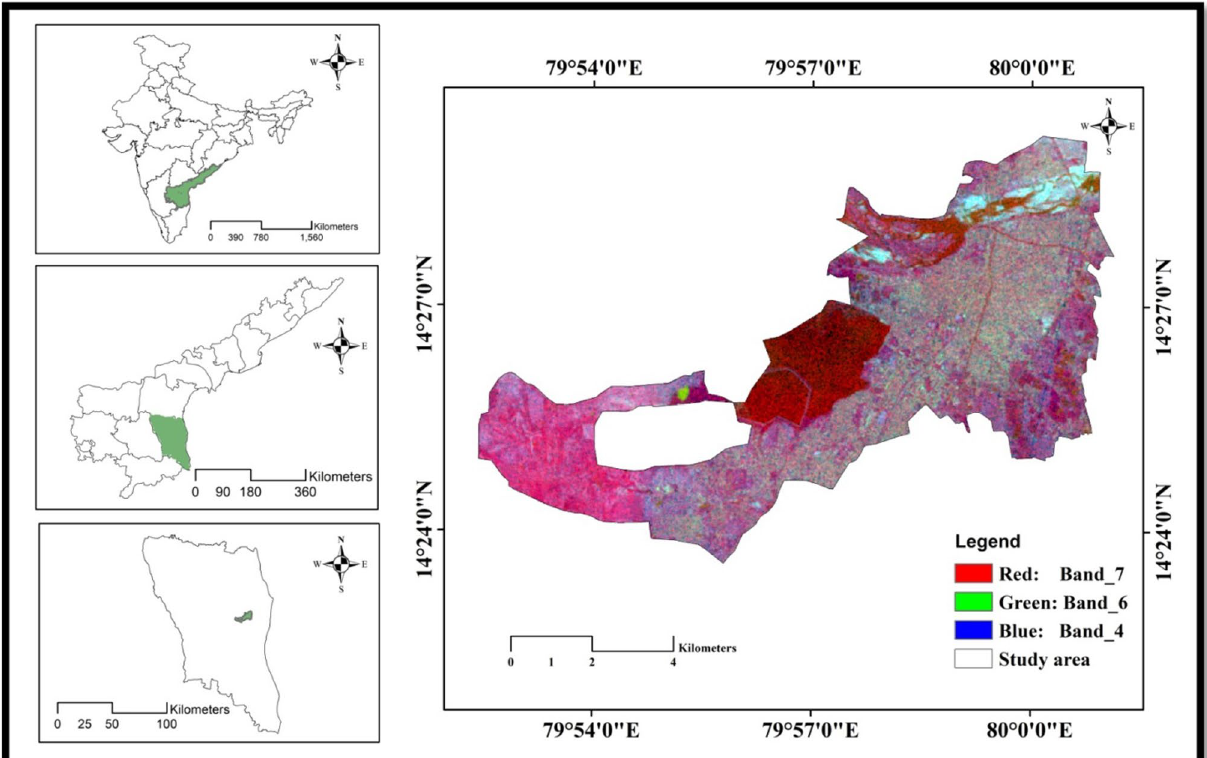
Fig. 1 Location map of the study